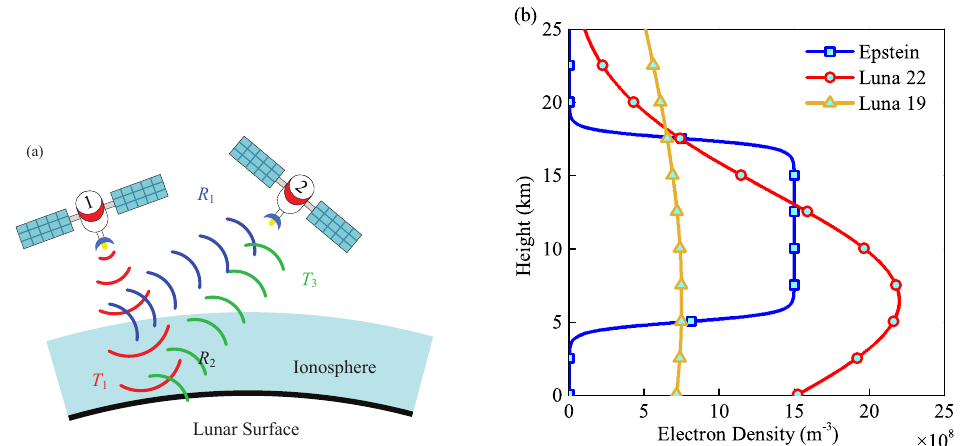
Figure 1. ( a ) Schematic of spaceborne radar detection and ( b ) the electron density profile of lunar